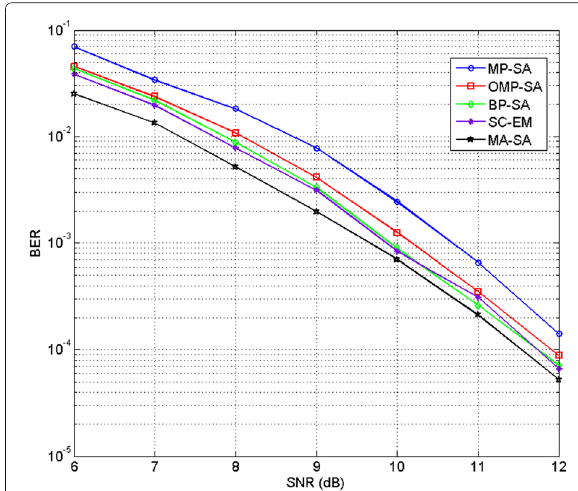
Fig. 5 Performance comparison between MP-SA, OMP-SA, BP-SA, SC-EM, and MA-SA. The performance for each method is computed using 10 4 length-100 sequences transmitted over a 10-tap channel with three active